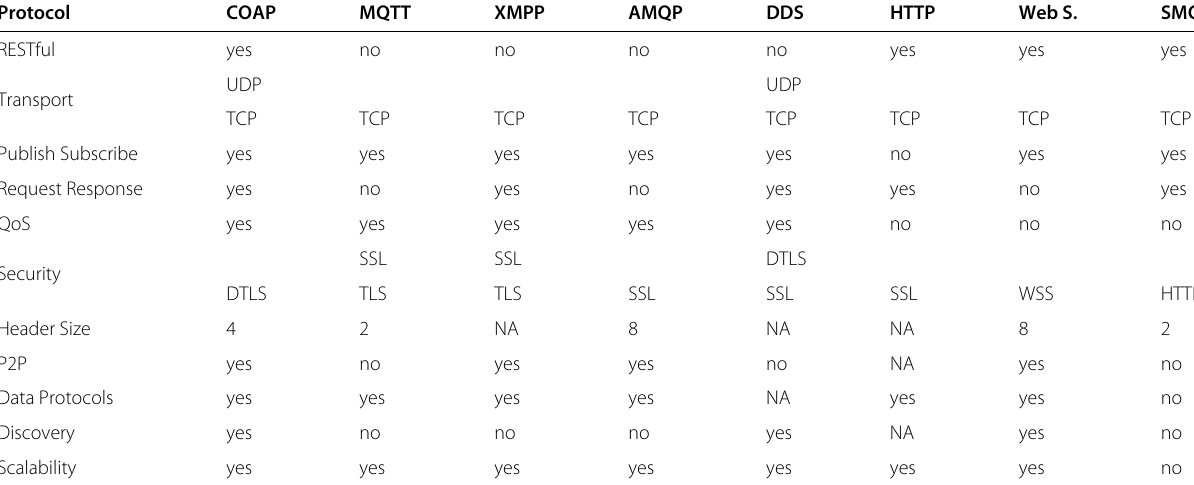
Table 1 Comparison of network protocols